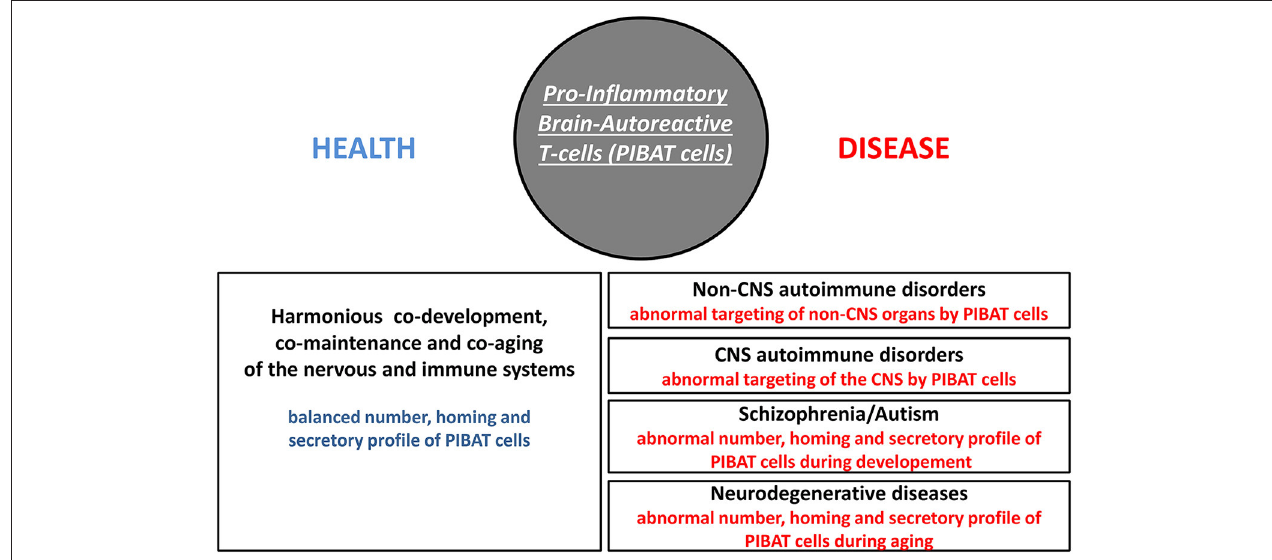
FIGURE 2 | Pro-inflammatory brain-autoreactive T-cells (PIBAT cells) in health and disease. Under physiological conditions, the number, secretory profile and homing properties of pro-inflammatory brain-autoreactive T-cells (PIBAT cells) supports finely-tuned cognition-promoting autoimmunity. In particular, PIBAT cells exert at distance trophic effects on neurons via cytokines and neurotrophins that are appropriately synthesized (qualitatively and quantitatively). Cognition-promoting autoimmunity allows an overall harmonious co-development, co-maintenance and co-aging of the nervous and immune systems. It is proposed that alterations in the number, secretory profile and/or homing behavior of PIBAT cells are involved in the pathophysiology of CNS autoimmune disorders, non-CNS autoimmune disorders, psychiatric diseases and neurodegenerative